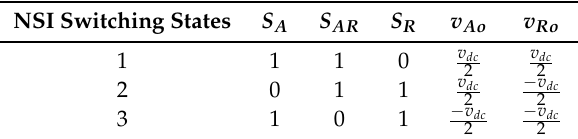
Table 1. Possible switching states and the respective output voltages for leg AR of the